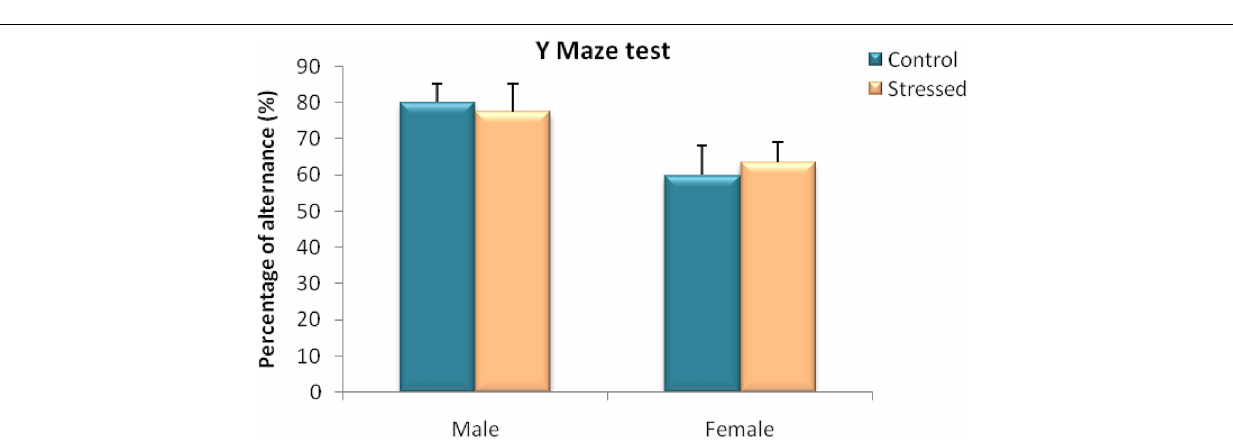
FIGURE 5 | Behavioral evaluation of spatial working memory disorders in male and female rats in a Y-maze spontaneous alternation test (% alternation). In both sexes cold stress had no effect on spatial working memory assessed in Y maze test. Each value represents the mean ± SEM ( n = 5); Effect of stress: ns p > 0.05 (ns: not